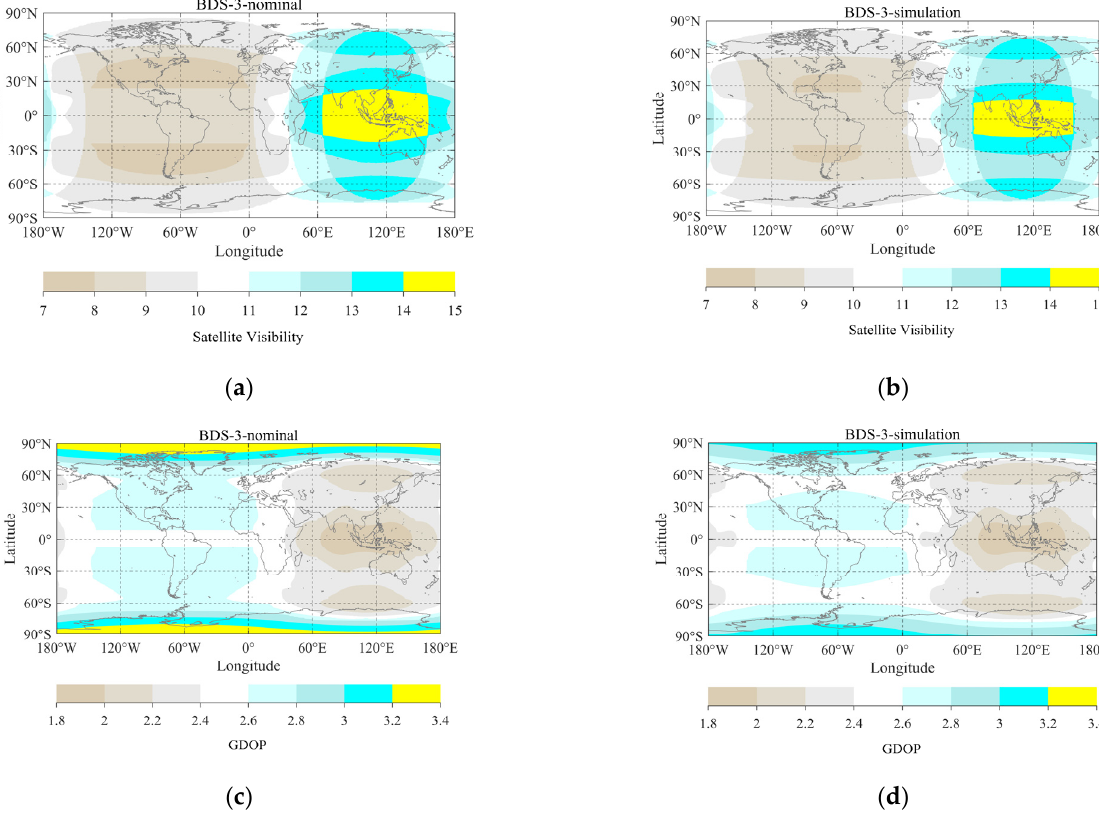
Figure 2. Satellite visibility and GDOP of BDS-3: ( a ) visible satellites of BDS-3-nominal; ( b ) visible satellites of BDS-3-simulation; ( c ) GDOP of BDS-3-nominal; ( d ) GDOP of BDS-3-simulation. Table 3. Statistical results of satellite visibility and GDOP for BDS-3-simulation, Galileo 2nd, 30- GLONASS, and the four-GNSS-NG, and its improvement rate compared to BDS-3-nominal, Galileo 1st, 24-GLONASS, and four-GNSS,